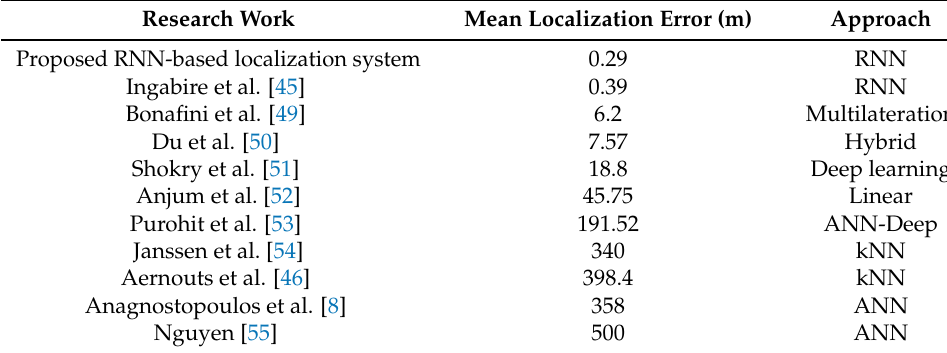
Table 3. Accuracy of different RSSI fingerprinting approaches in outdoor LoRaWAN from different research